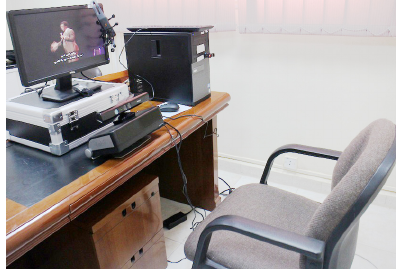
Figure 4. Recording setup and